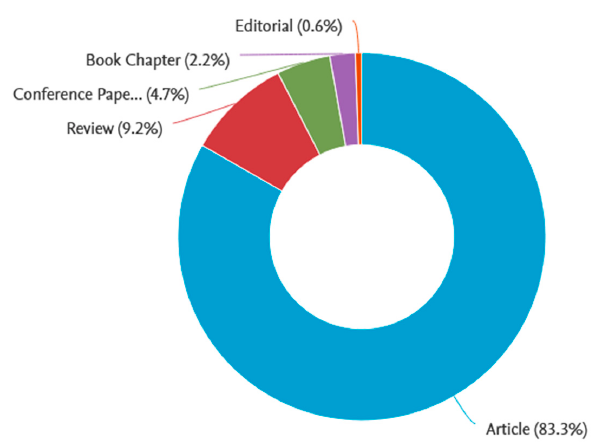
Figure 3. Distribution of papers.